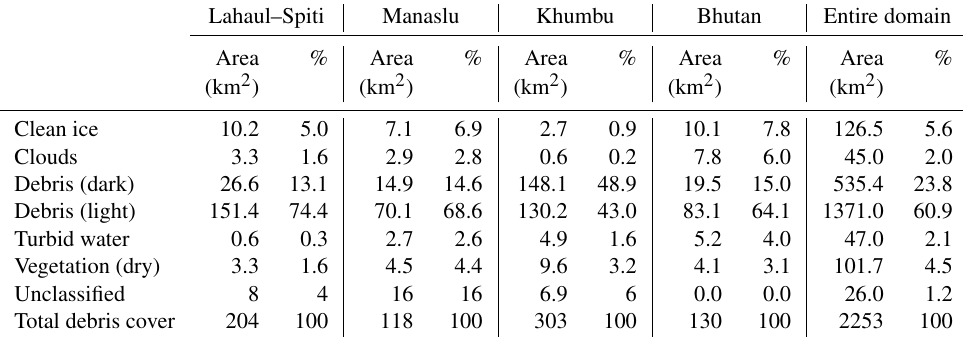
Table 6. Composition of the debris-covered glaciers over the entire Himalaya domain and four selected sub-domains along the monsoonal gradient and for the entire domain, listed from west to east. Debris-covered glacier areas are based on the SDC dataset (Scherler et al.,